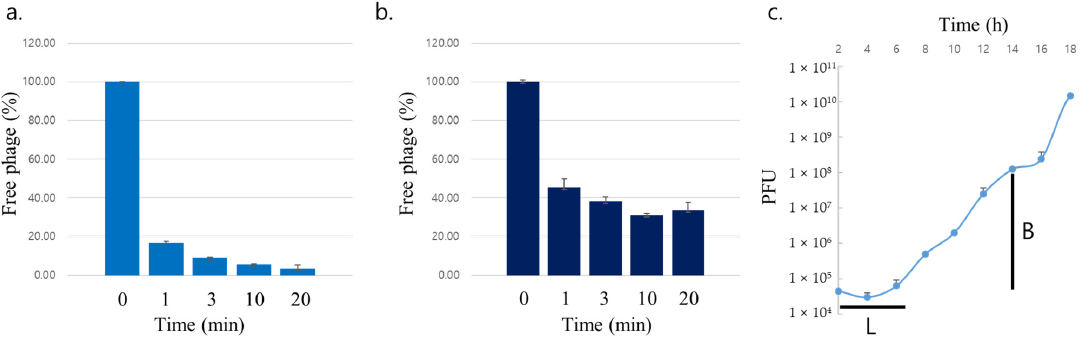
Figure 4. Adsorption assays of 2012-15 phage using Cutibacterium acnes ATCC 11827 ( a ) and Staphy- lococcus aureus ATCC 25923 ( b ). One-step growth curve of 2012-15 phage with Cutibacterium acnes ATCC 11827 ( c ). L stands for the latent period and B for the burst size of the phage. S. aureus ATCC25923 was also used in the 2012-15 phage adsorption assay. Interest- ingly, the phages could attach to S. aureus , but not to CA. After 1 min, more than half of